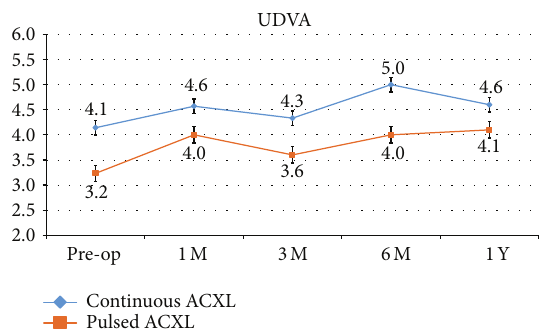
Figure 1: Uncorrected distance visual acuity (UDVA) after con- tinuous light (blue line) and pulsed light (orange line) accelerated crosslinking gained +0.5 and +0.9 decimal equivalents, respectively, at one-year